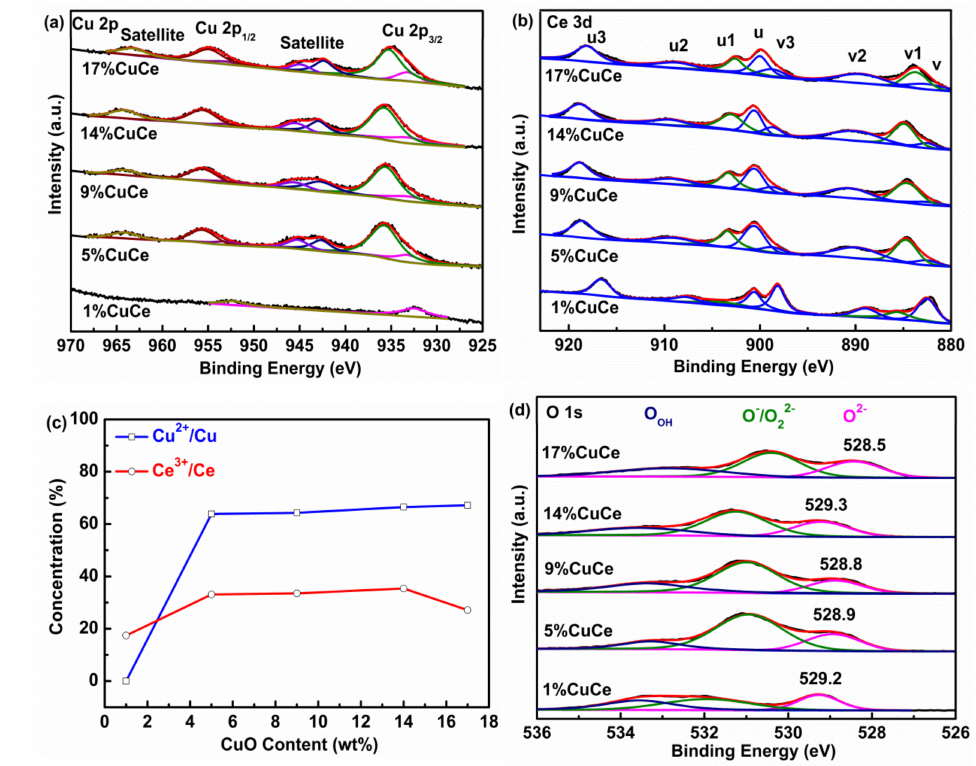
Figure 4. ( a ) Cu 2p X-ray photoelectron spectroscopy (XPS) spectra; ( b ) Ce 3d XPS spectra; ( c ) the variation tendency of ratios of Cu 2+ and Ce 3+ for the samples with different CuO contents; ( d ) O 1s XPS